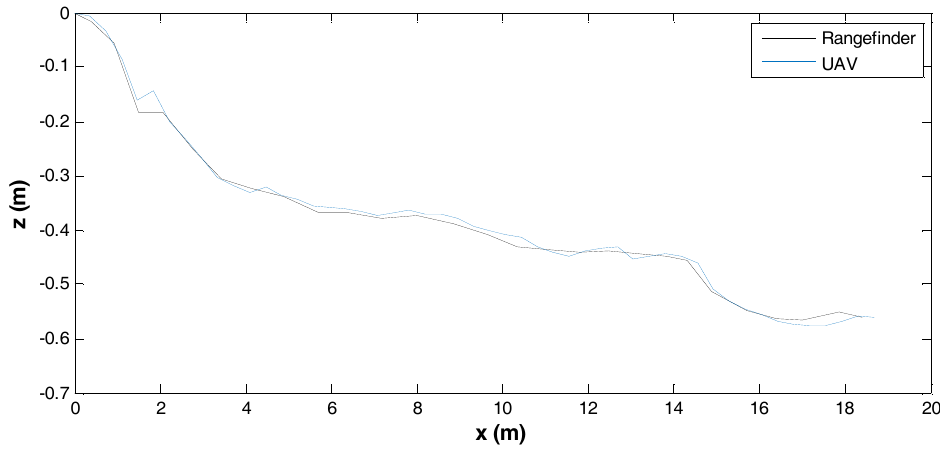
Figure 9. Comparison of elevation measured over the pitcher mound.